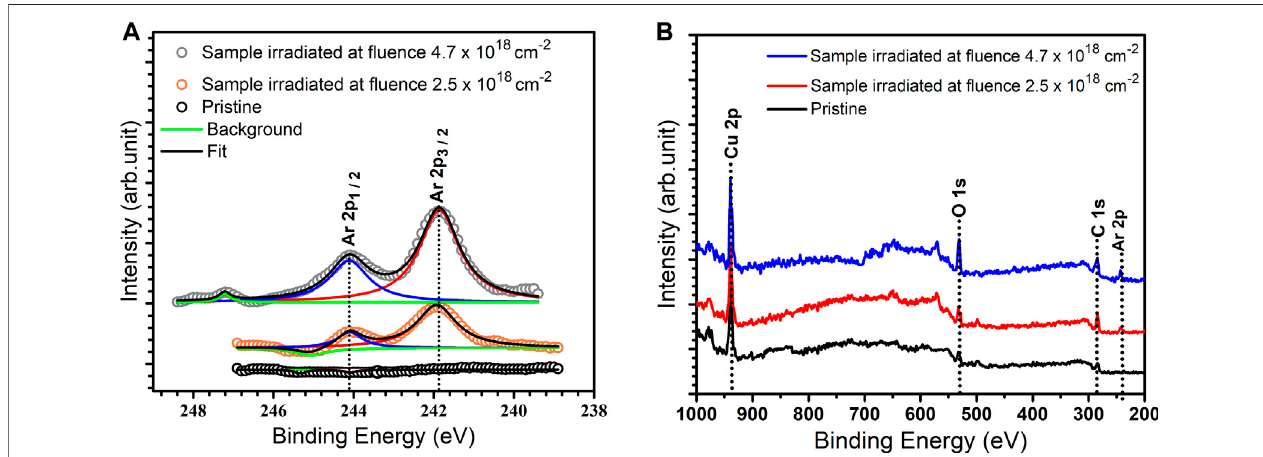
FIGURE 5 | High-resolution X-ray photoelectron spectroscopy (XPS) spectra in (A) and X-ray photoelectron spectroscopy (XPS) survey spectra in (B) for two chosen argon-bombarded copper surface compared to pristine.